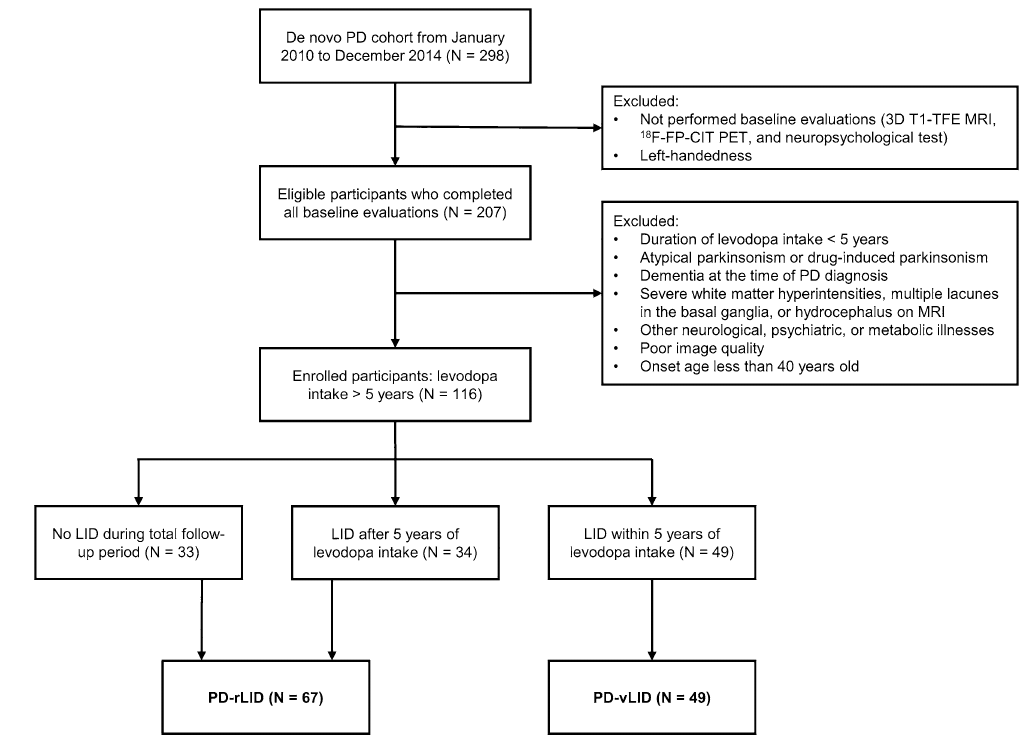
Figure 3. Flowchart of enrollment of the study